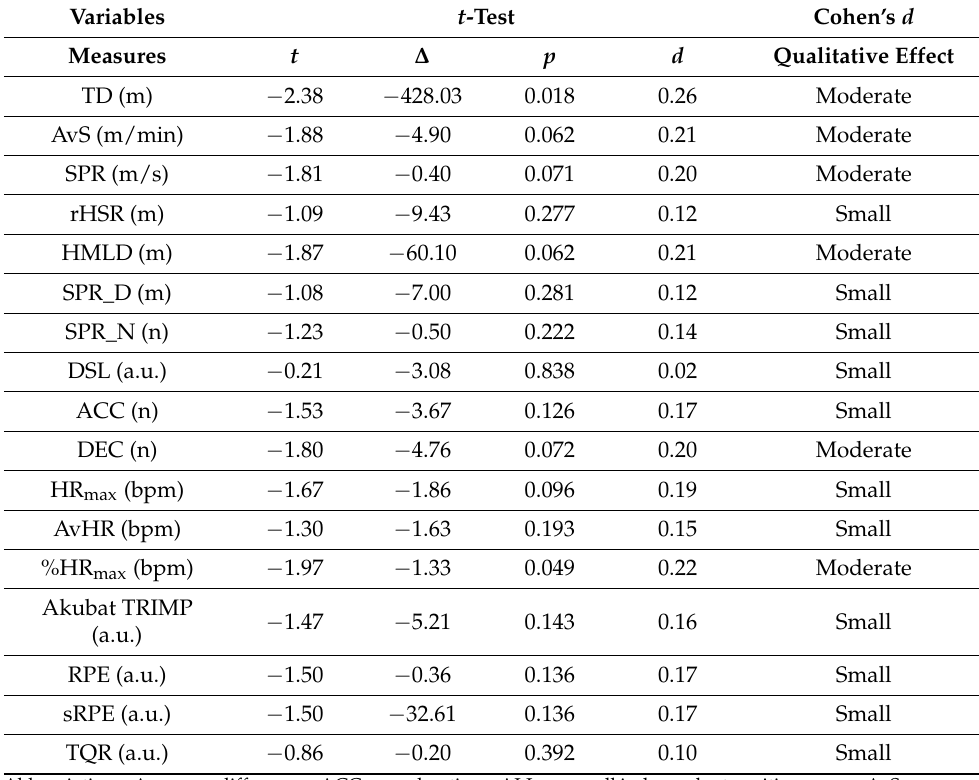
Table 3. Mean differences between starters and non-starters in the weekly training